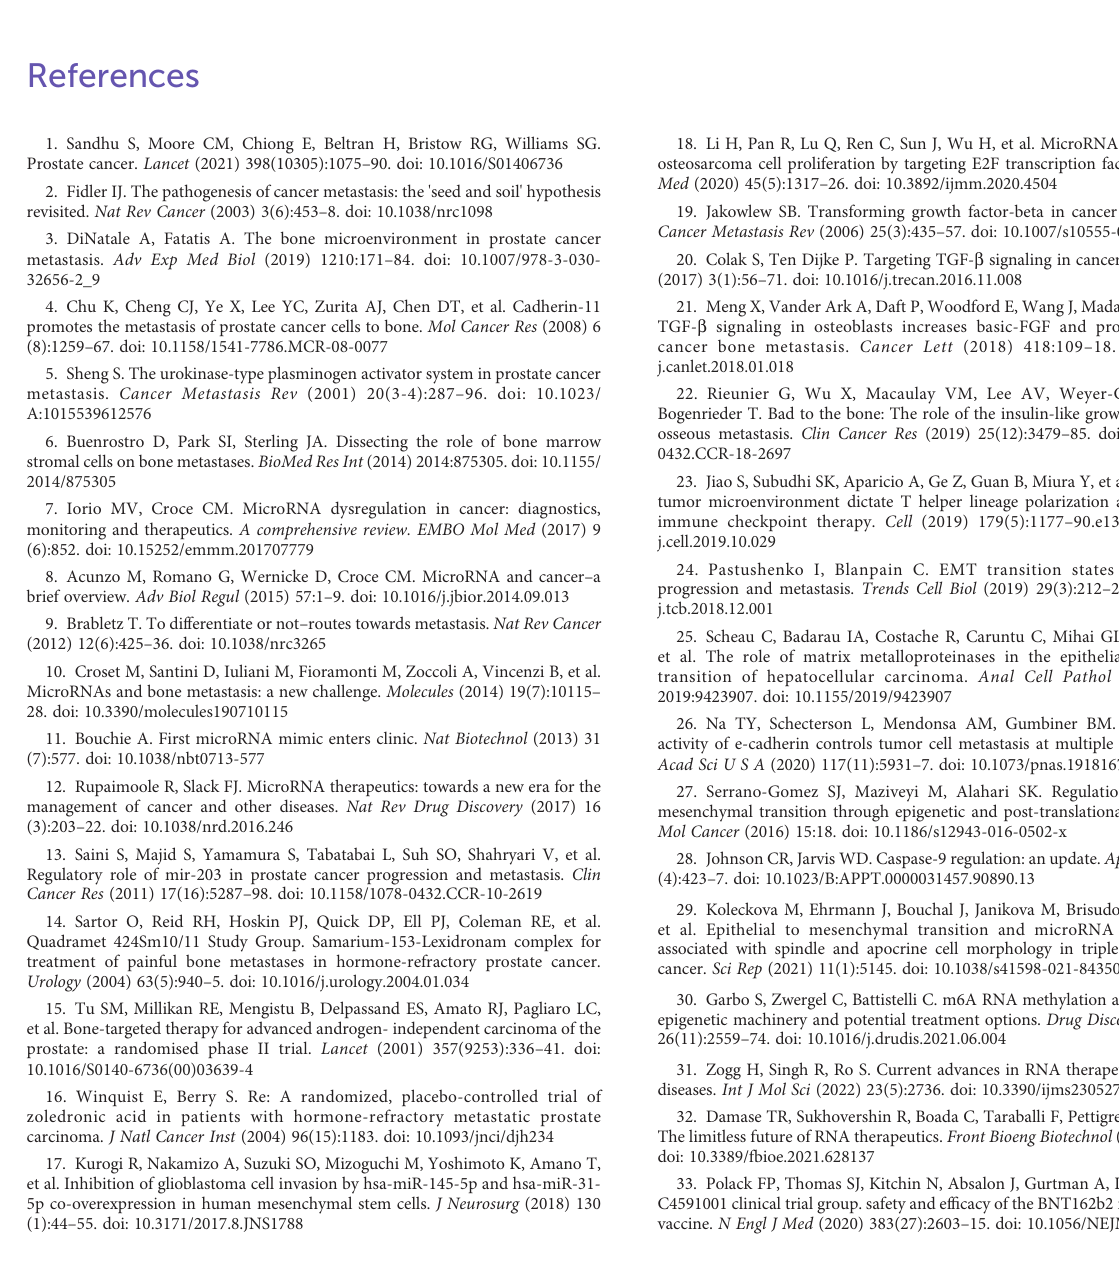
SUPPLEMENTARY TABLE 1 A List of differentially expressed genes associated with bone metastases from prostate